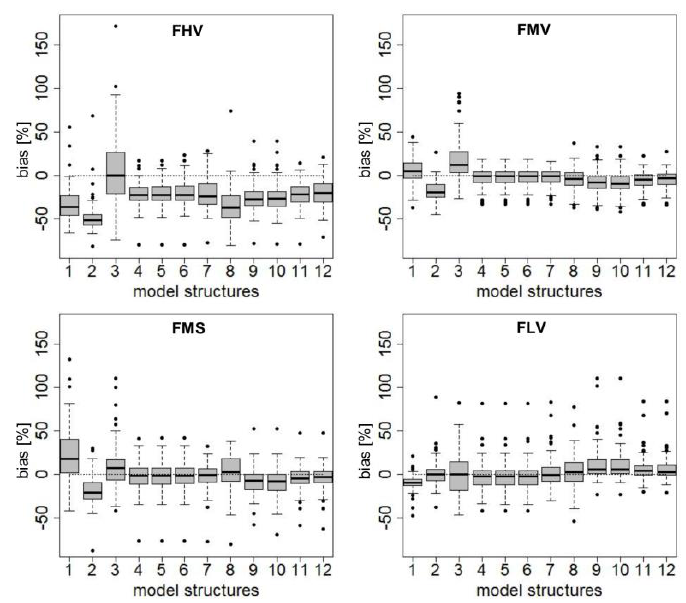
Figure 4. Box and whisker plots of the four signature indices of all models and 12 model structures. The boxplots show the interquartile ranges as boxes and the median by a black line in the middle of the box; the whiskers show the minimum and the maximum up to the 1.5 interquartile range and outliers outside the 1.5 interquartile range.